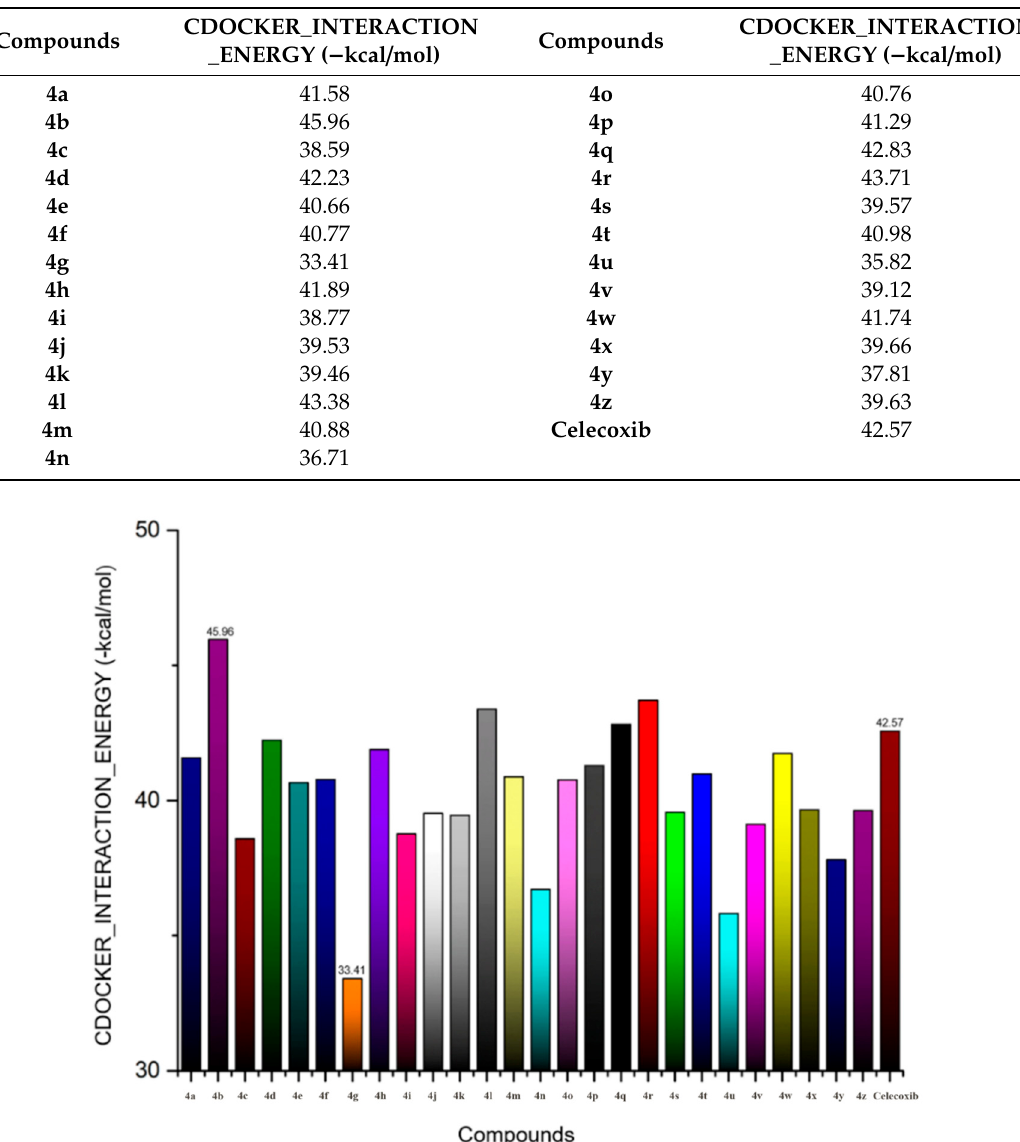
Figure 7. The fitting correlation between the binding energy and COX-2 inhibition.